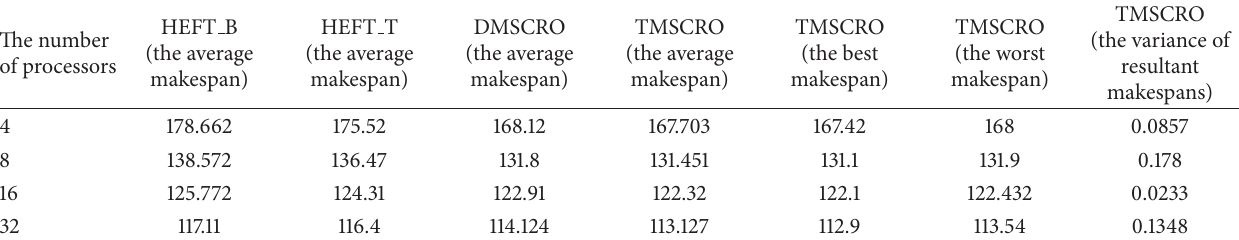
Table 13: The experiment results for the random graph under different processors, CCR = 1.0; the number of tasks is 50. The number